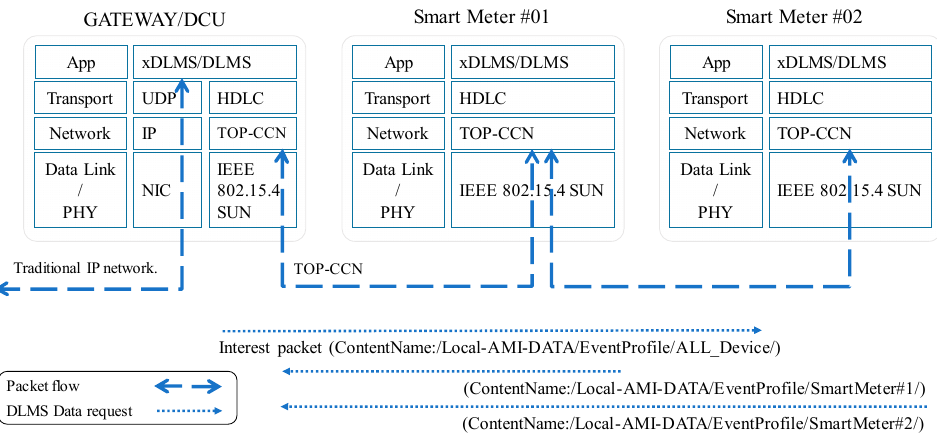
Figure 3. An operation example of Topology Aware Content Centric Networking (TOP-CCN) for LMN.